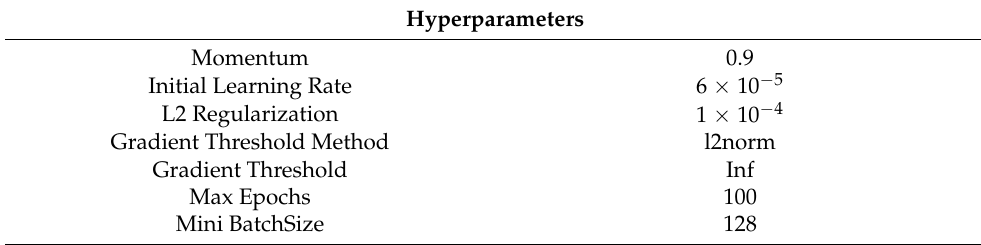
Table 3. The hyperparameter values used in the proposed